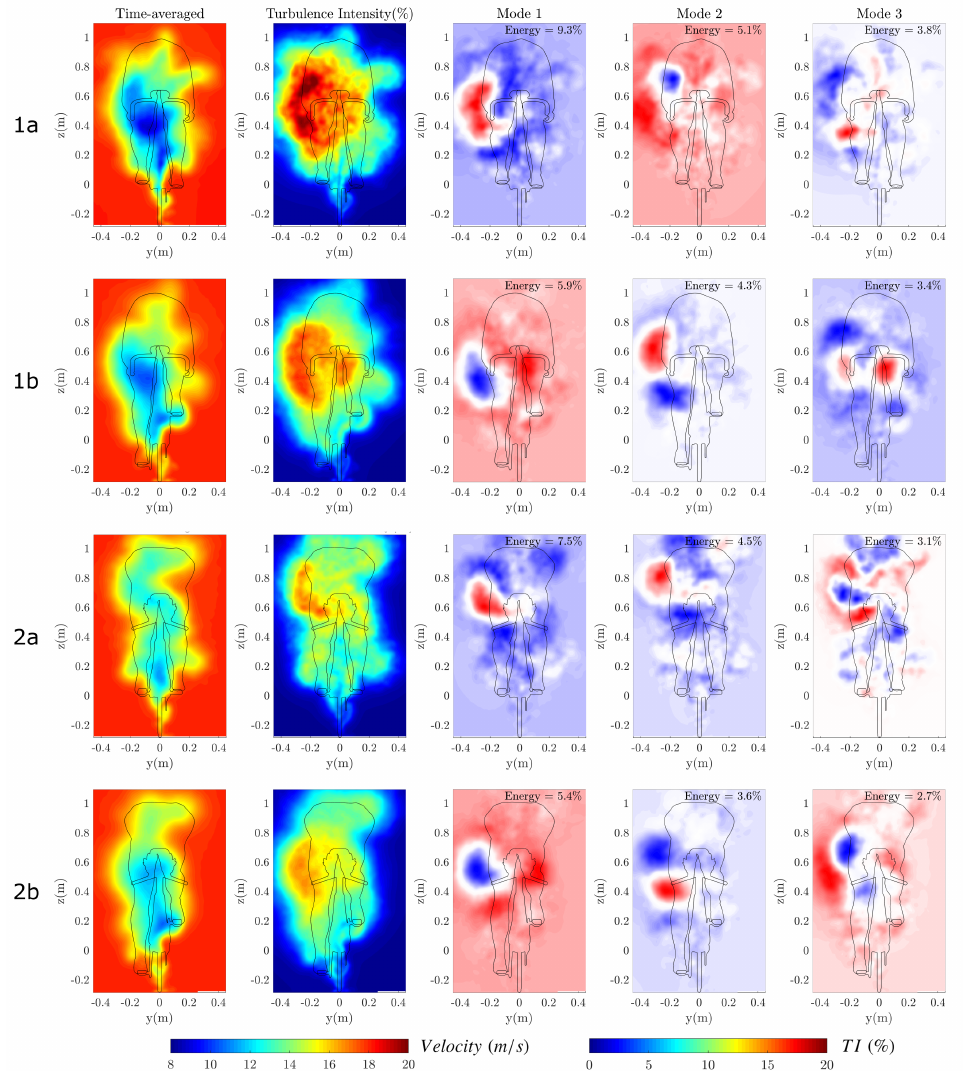
Figure 10. The wake dynamics presented by the time-averaged velocity (column 1), turbulence intensity (column 2), and the structure of first three most energetic modes (column 3 ∼ 5) at 1 C behind the back of the cyclist. The outlines of the cyclist and bicycle are also plotted here to show the relative position between the wake and